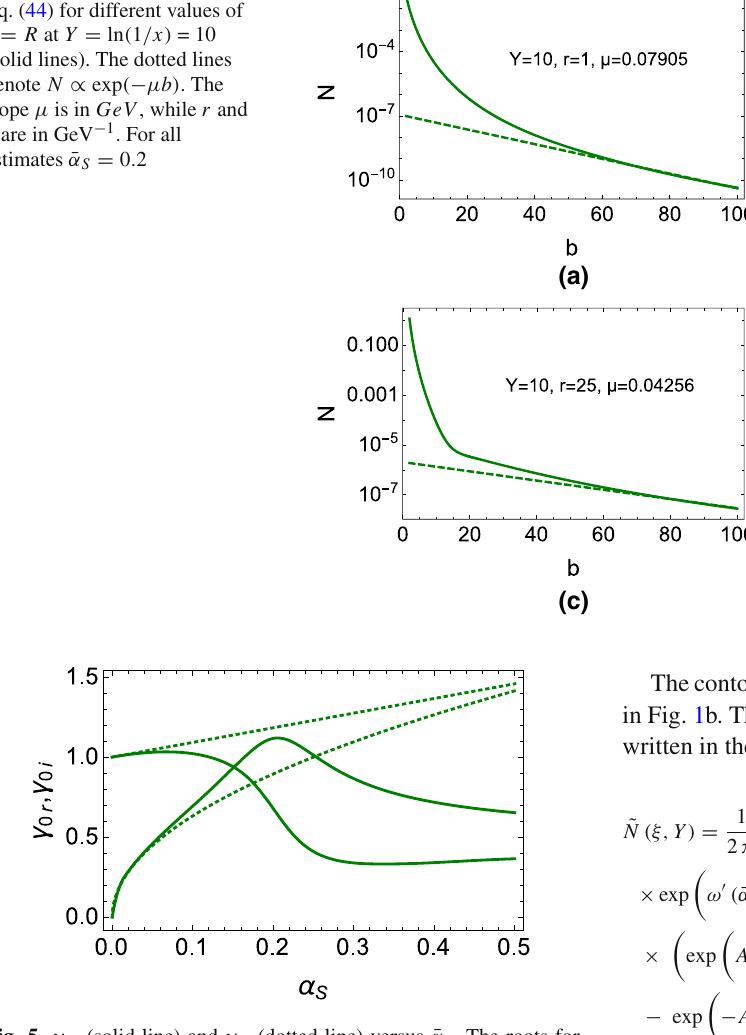
Fig. 5 γ 0 r (solid line) and γ 0 i (dotted line) versus ¯ α S . The roots for the DLA approach (see Eq. (23)) are shown by the dotted lines. In this / 2 case γ 0 r = 1 + ¯ α S and γ 0 i = 2 ¯ α 1 S